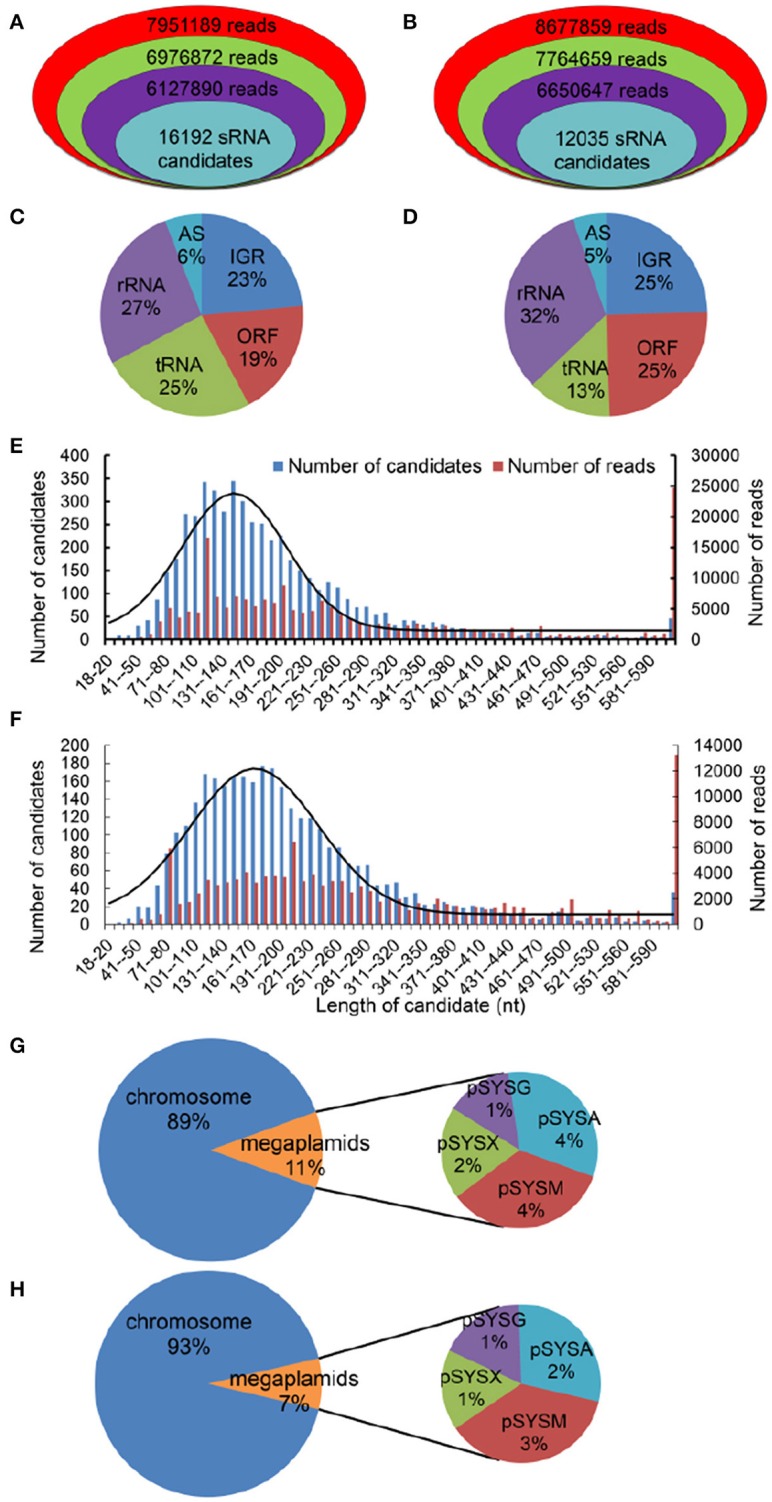
High-resolution transcriptomes of Synechocystis, as determined by sRNA-seq. Visual representation of the depth of the sRNA-Seq data reads under NL (A) and HL (B) conditions. Reads that represent total sequence are in red; reads that are larger than 18 nt are in green; reads that match the Synechocystis genome are in purple. All the number of sRNAs (turquoise) after filtering were amongst these candidates. Breakdown of total Synechocystis reads based on their genomic origin under NL (C, n = 6,127,890) and HL (D, HL, n = 6,650,647) conditions. ORF, annotated open reading frames; AS, transcripts antisense to known genes; IGR, transcripts from intergenic regions. Length distribution of sRNA candidates (≥10 reads) and total reads. The 5,261 and 3,379 sRNA candidates (≥10 reads) under NL (E) and HL (F) conditions, corresponding to 197,304 and 125,023 total reads, are plotted based on the length of the most abundant sequence observed for each candidate. The fitted gaussian distribution is indicated in black. Location distribution of two sRNA databases, under NL (G) and HL (H) conditions, in the Synechocystis chromosome and its four megaplasmids (pSYSA, pSYSG, pSYSM, and pSYSX).